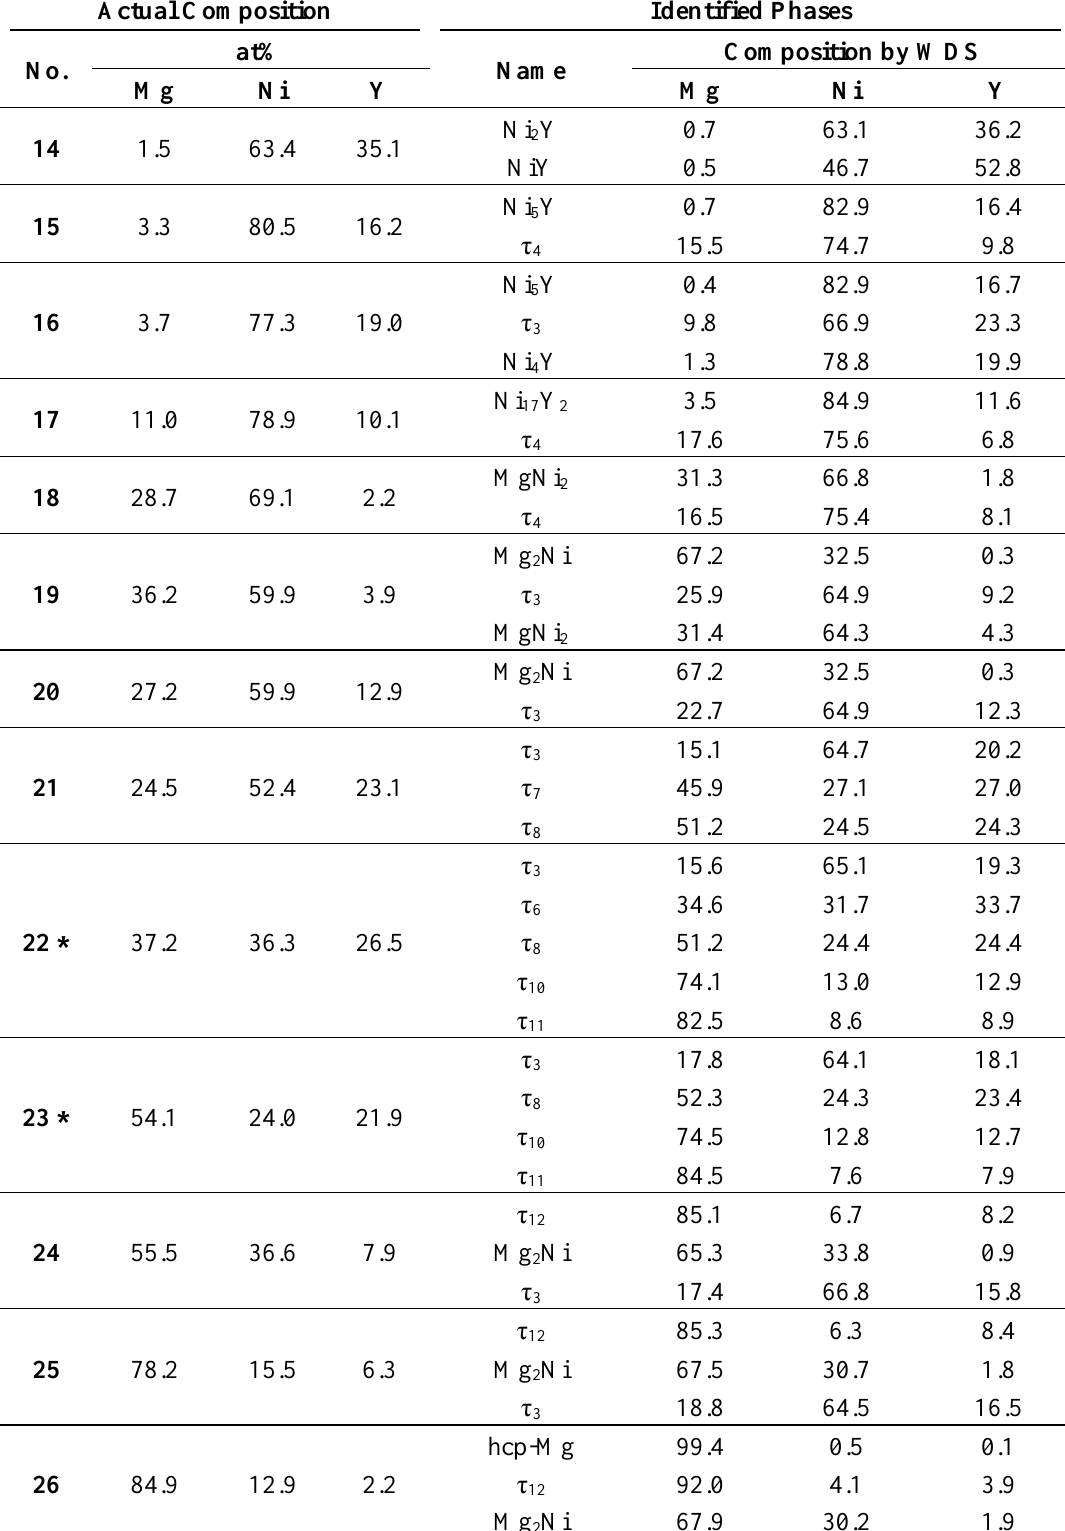
Table 6. WDS data of the samples 14–26 annealed at 673